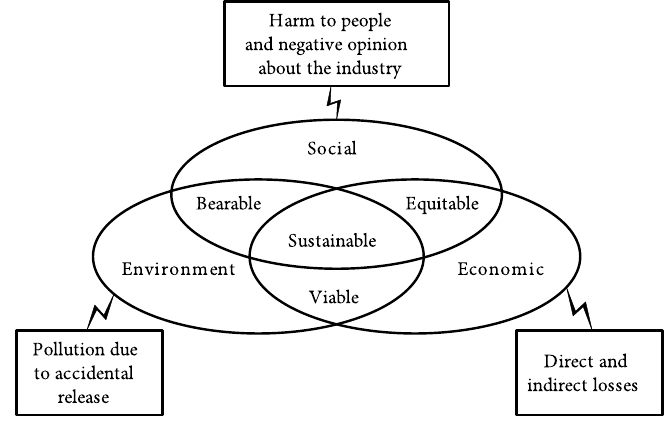
fig. 1. Three constituent parts of sustainable development (in ovals) and restricting influence of industrial accidents on this process (in